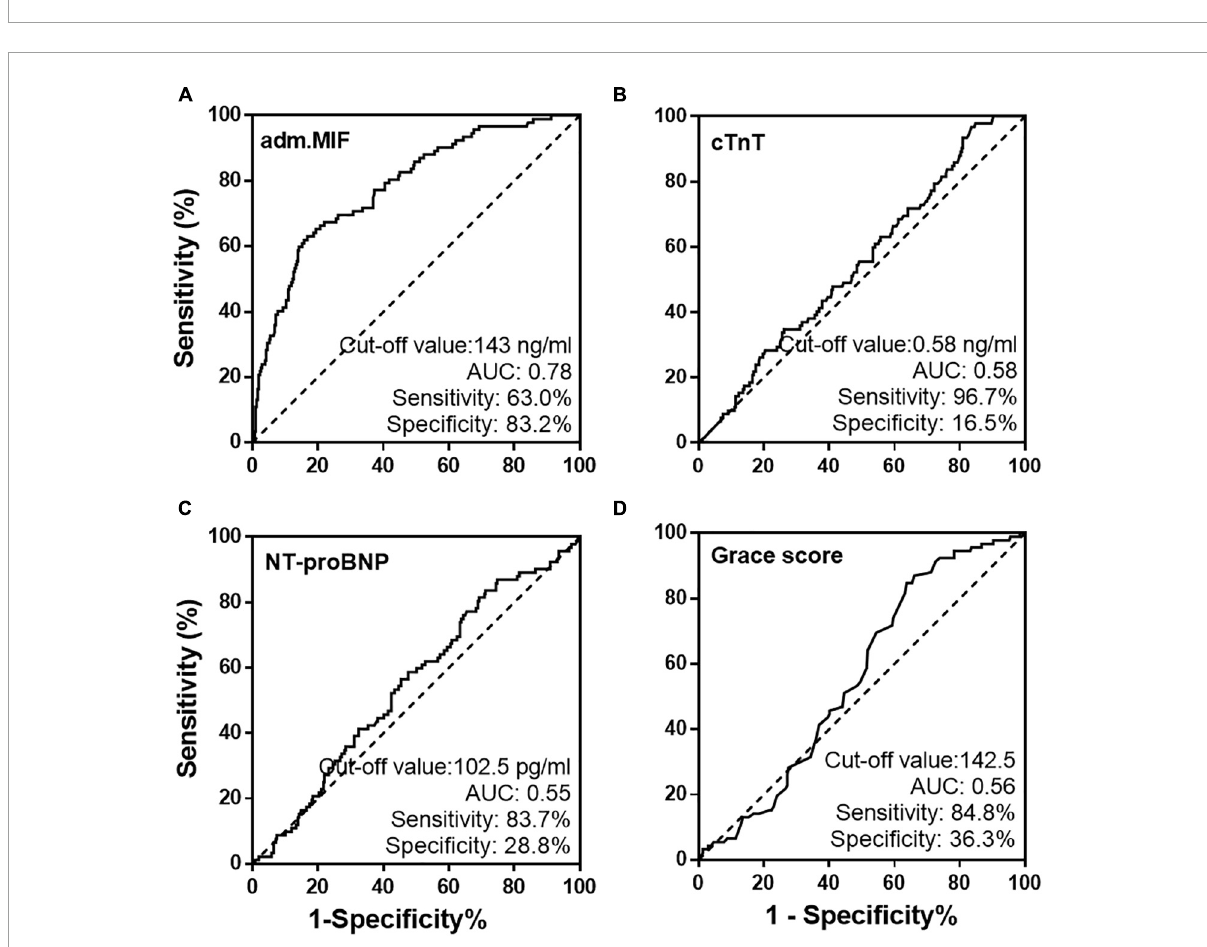
Figure 4A , P = 0.016) at the end of the follow-up period. In the STEMI with MetS group, the prevalence of MACCE was markedly higher in patients with high-MIF levels (76.9%) than